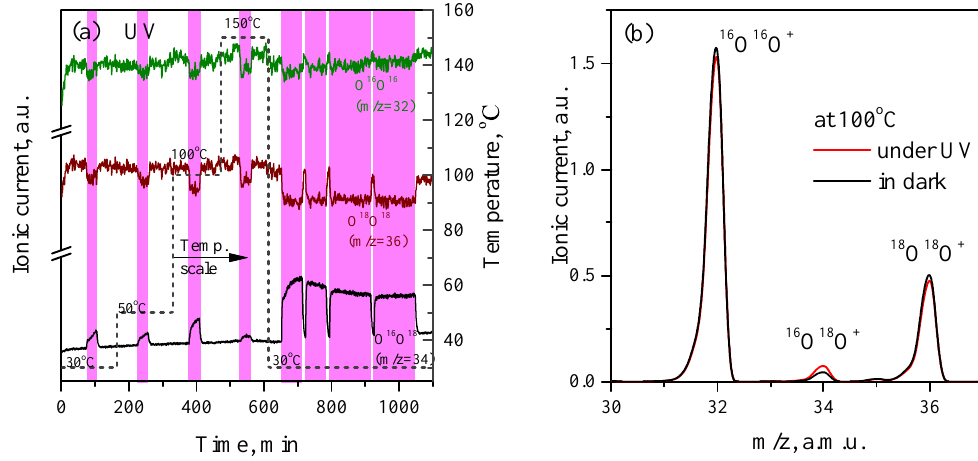
Figure 3. ( a ) MS analysis of the content of oxygen molecules with various isotopic compositions ( 16 O 16 O, 32 a.m.u.; 16 O 18 O, 34 a.m.u.; 18 O 18 O, 36 a.m.u.) in the carrier gas passed through the cell with ZnO tablets and the effect of UV irradiation on its concentration at temperatures of 30, 50, 100, and 150 ◦ C. After sample cooling, the effect of enhancement of POIE at room temperature is observed. ( b ) Mass spectrum of the carrier gas in the range of 30–37 a.m.u. at 100 ◦ C in dark and under UV irradiation (350th and 400th minutes of the experiment in ( a